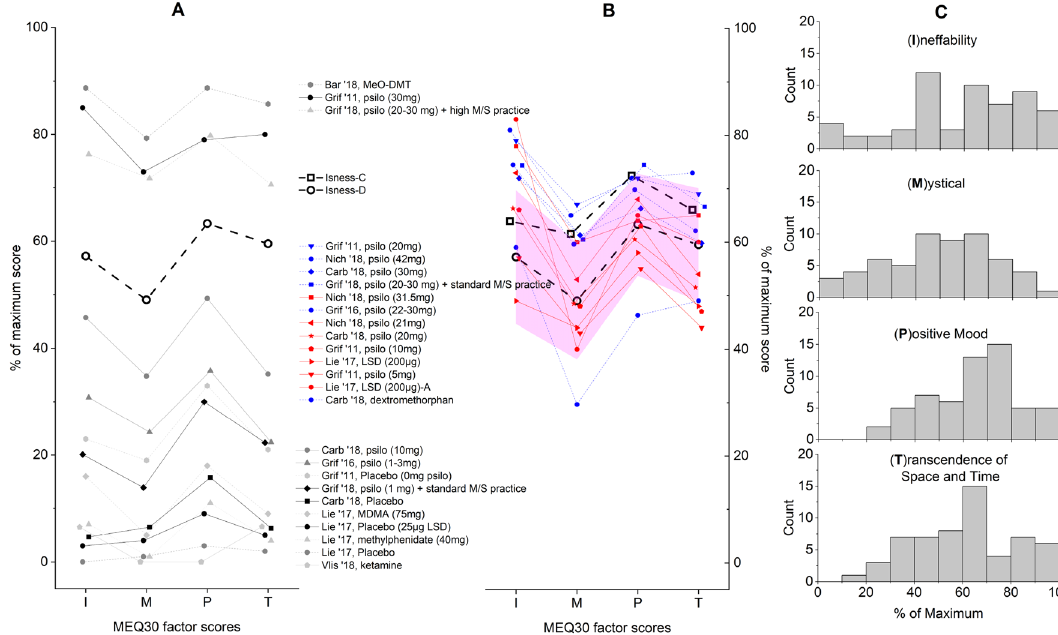
Figure 4. Comparison of the average ( I , M , P , T ) factor scores of Isness-D to Isness-C 25 and previously published research studies that have employed the MEQ30 (Bar ’18 74 , Carb ’18 77 , Griff ’11 14 , Grif ’16 79 , Grif ’18 75 , Lie ’17 78 , Nich ’18 76 , Vlis ’18 81 , and Isness-C 25 ). ( A ) shows the average factor scores for the studies that were statistically distinguishable from Isness-D (p < 0.05). ( B ) shows studies that were statistically indistinguishable from Isness-D on at least 2 factors (p > 0.05), where the blue lines indicate a study with two factor scores indistinguishable from Isness-D, and the red lines indicate a study with three or four factor scores indistinguishable from Isness-D. The area highlighted in pink shows the approximate region within which a factor score was determined to be indistinguishable at a 5% confidence level. ( C ) shows the distribution of the four factor scores of the MEQ30 results of